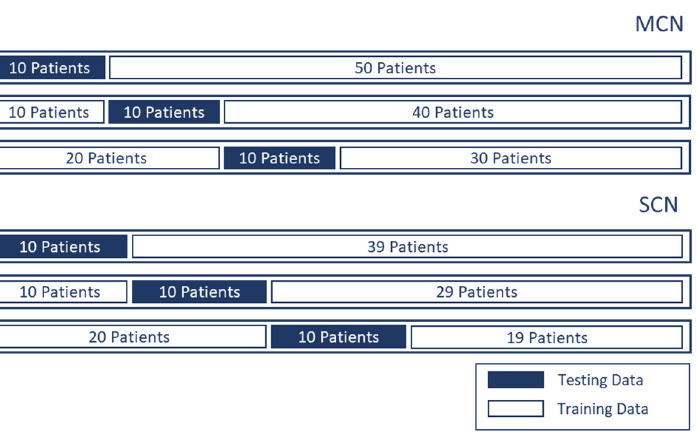
Figure 3. Three groups of holdout validation. Ten patients were selected from each class for testing and the rest were used to provide training data.